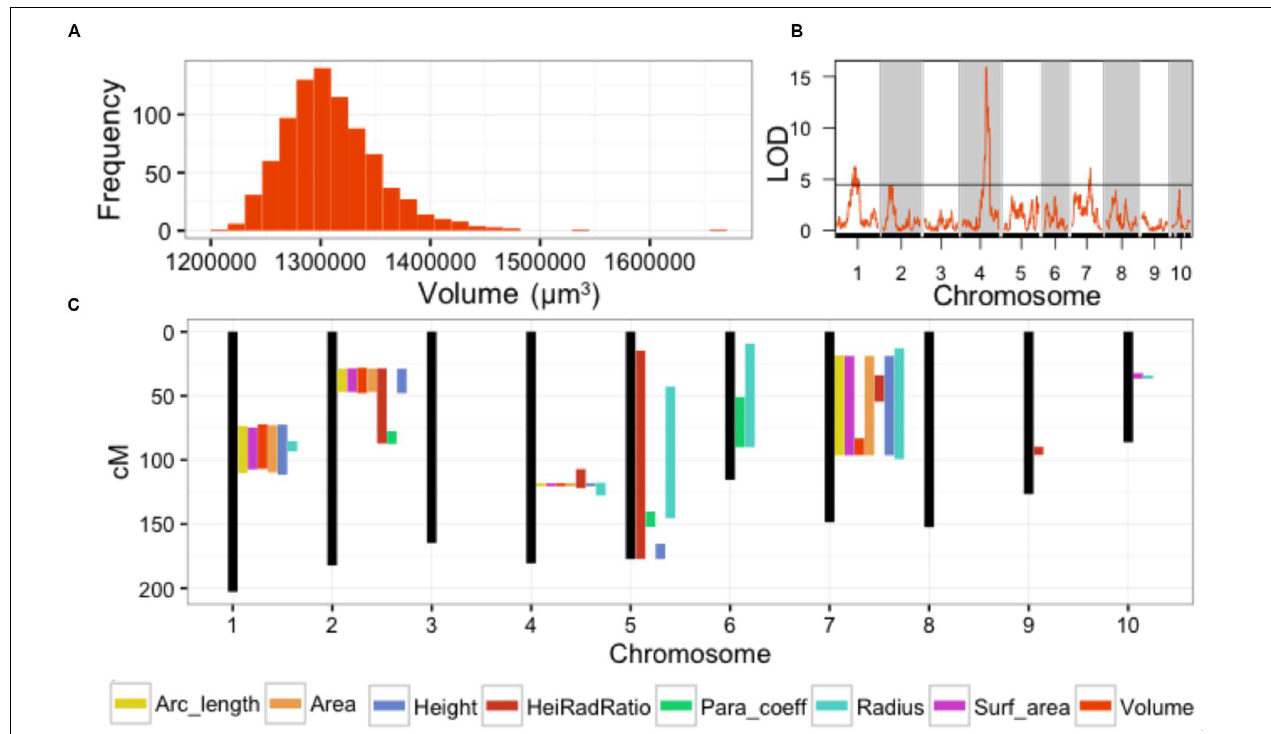
FIGURE 2 | Parabolic estimators of MxT line SAM shape and size identify meristem morphology QTL. (A) Volume measures of SAMs harvested from 841 BC2S3 MxT lines. Measures are BLUP + coefficient values from 2 replicates. (B) Single QTL models detect significant loci for SAM volume on chromosome 1, 4, and 7. Black line, significance threshold a = 0.05. (C) Additional significant SAM morphology QTL are detected for all 8 parabolic estimators